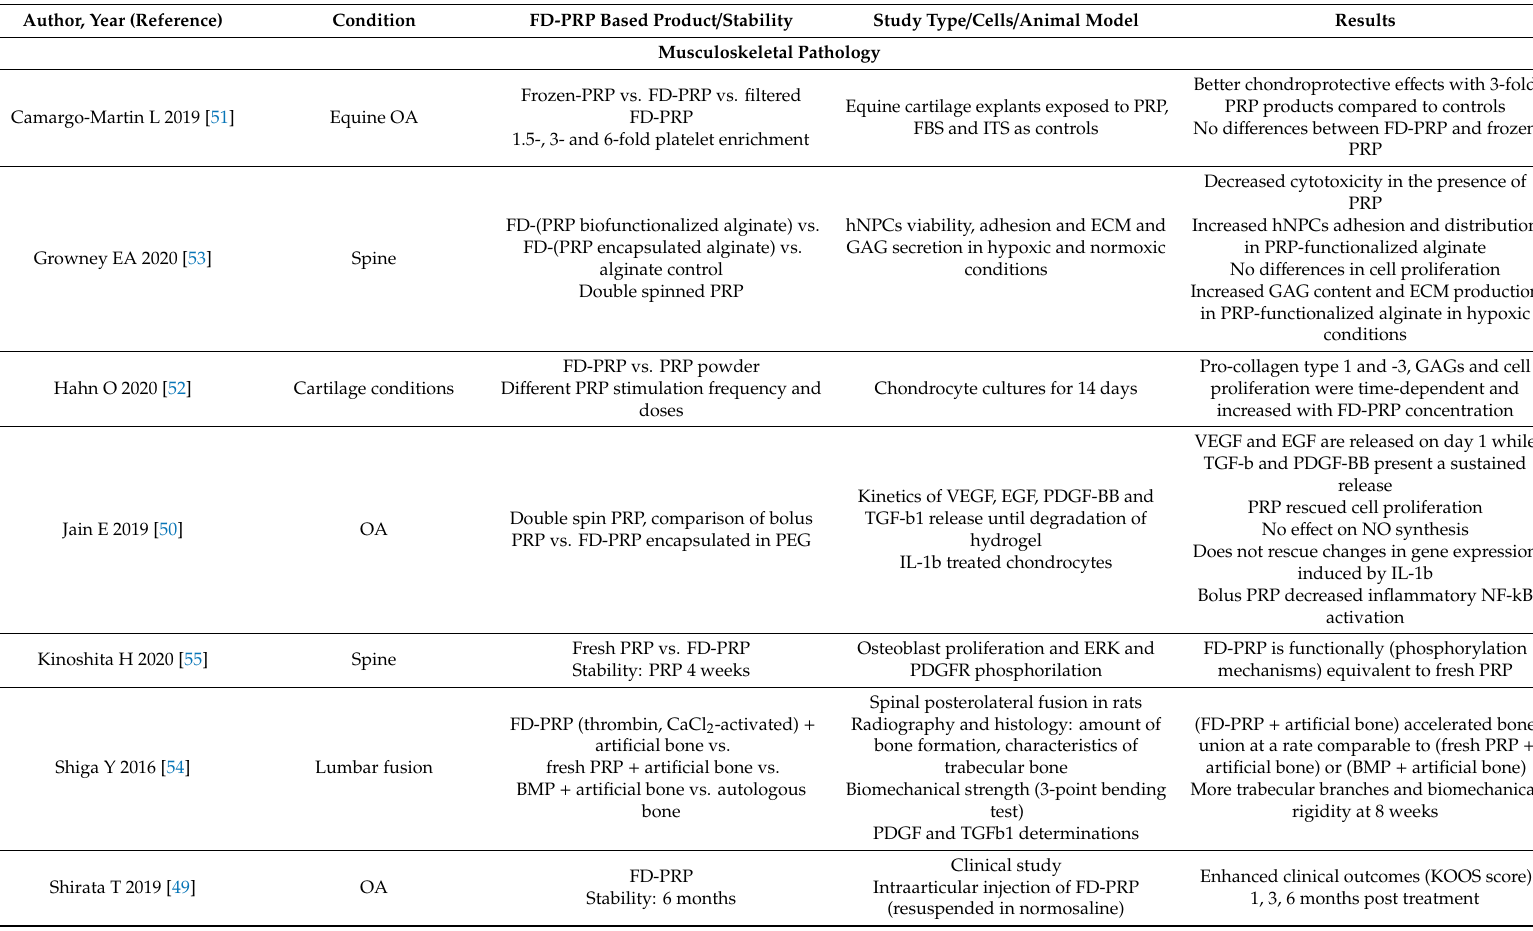
Table 2. Studies in musculoskeletal